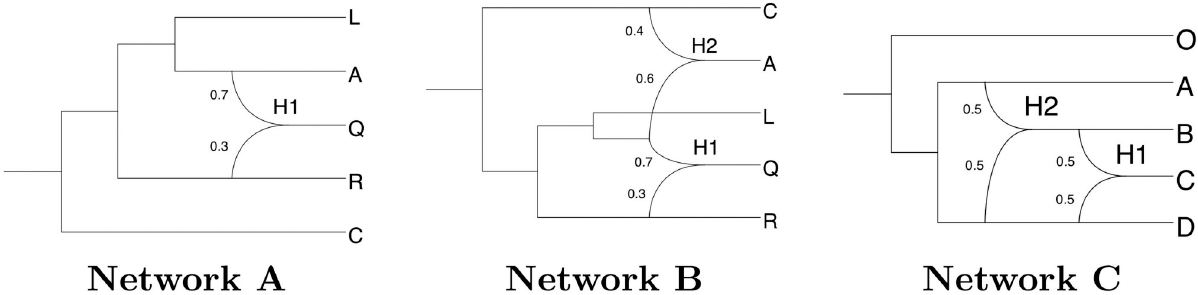
Fig 7. The three phylogenetic networks used for simulating data. Networks A and B are taken from [54]. Branch lengths are measured in units of expected number of mutations per site (i.e. substitutions per site). Displayed values represent inheritance probabilities.